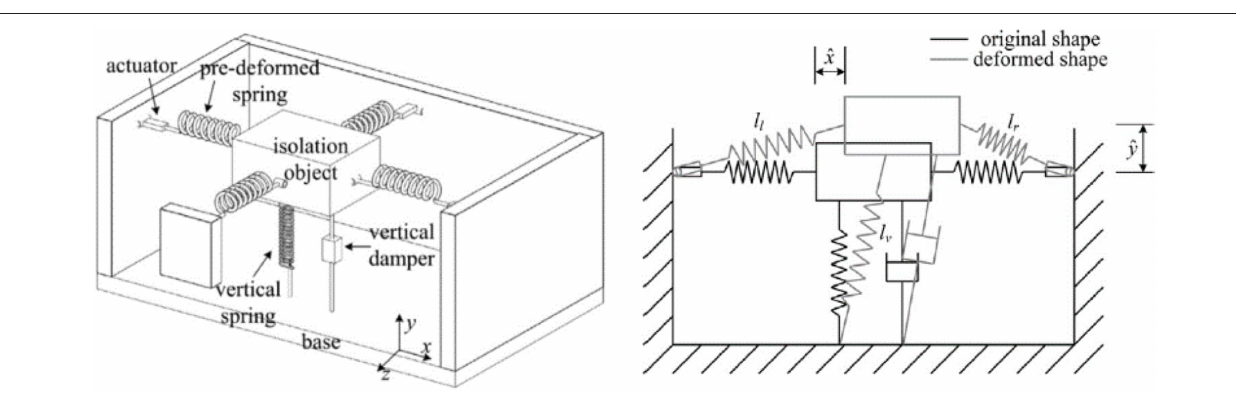
FIGURE 6 | The structural diagram of the multi-direction isolation system (Sun and Jing, 2015).